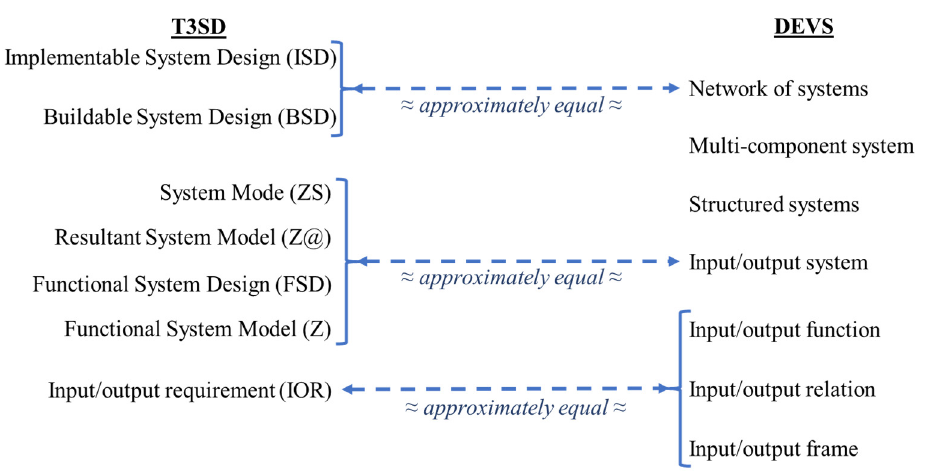
Figure 14. Conceptual overlay of T3SD terms (left-side) and DEVS (right-side). This figure shows the approximate equivalence between T3SD elements and DEVS elements. There is no equivalence of the DEVS elements multi-component system and structured system to T3SD elements.